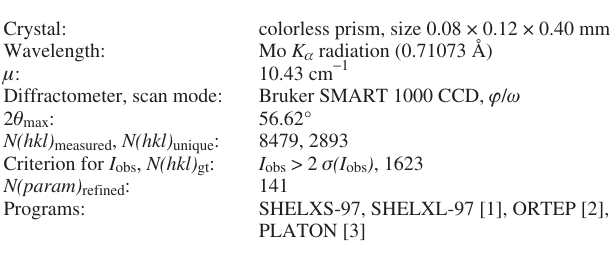
Table 1. Data collection and handling.